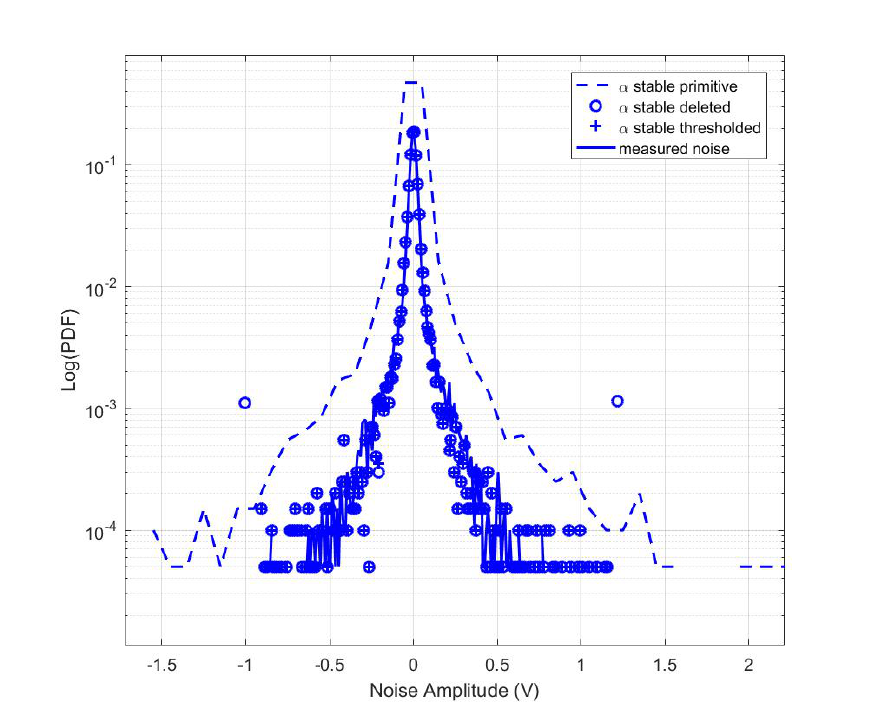
Figure 13. log(PDF) comparison of α stable primitive noise, α stable thresholded noise and measured noise data in